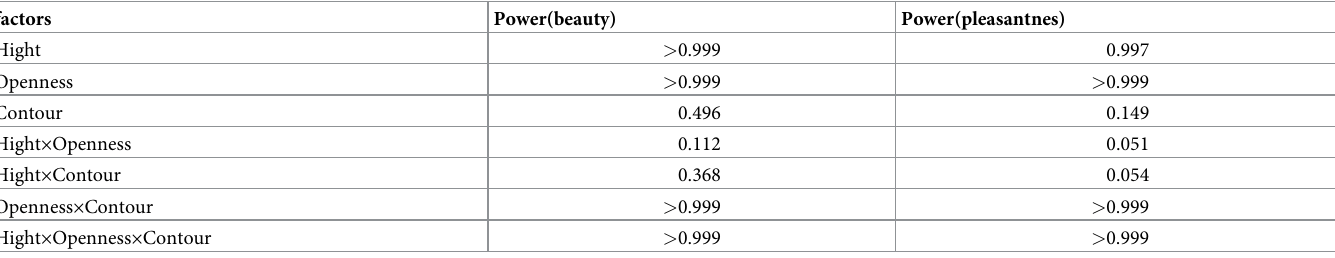
rectilinear contours or higher ceilings and curvilin- ear contours, more open space is more likely to lead to a higher beauty and pleasantness score than is less open space (p < 0.05). Among the 4 combinations, compared to lower ceilings, higher ceilings were more likely to lead to a higher beauty and pleasantness score (p < 0.05). We used PASS vesion 15.0 software to calculate the effectiveness power. based on our study data, after entering the values of the parameters required by the software such as sample size = 29, test level α = 0.05, ρ (Autocorrelation) for each independent variable and the mean and standard deviation for each group, the power of each term of the model was calculated as Table 4. Table 4. Power